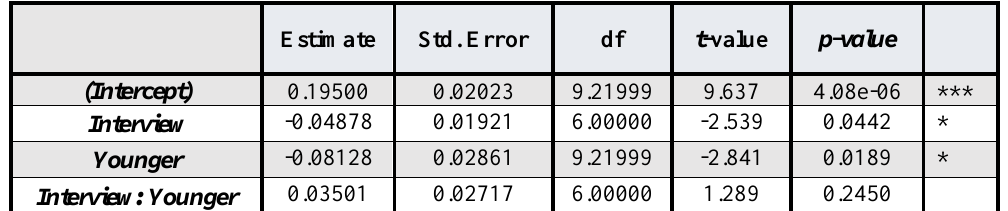
Table 4. Regression coefficients for the mixed linear effects model predicting vowel space area. The Intercept coefficient is vowel space area from word list productions by older speakers and the estimates are squared measures of normalized frequency.